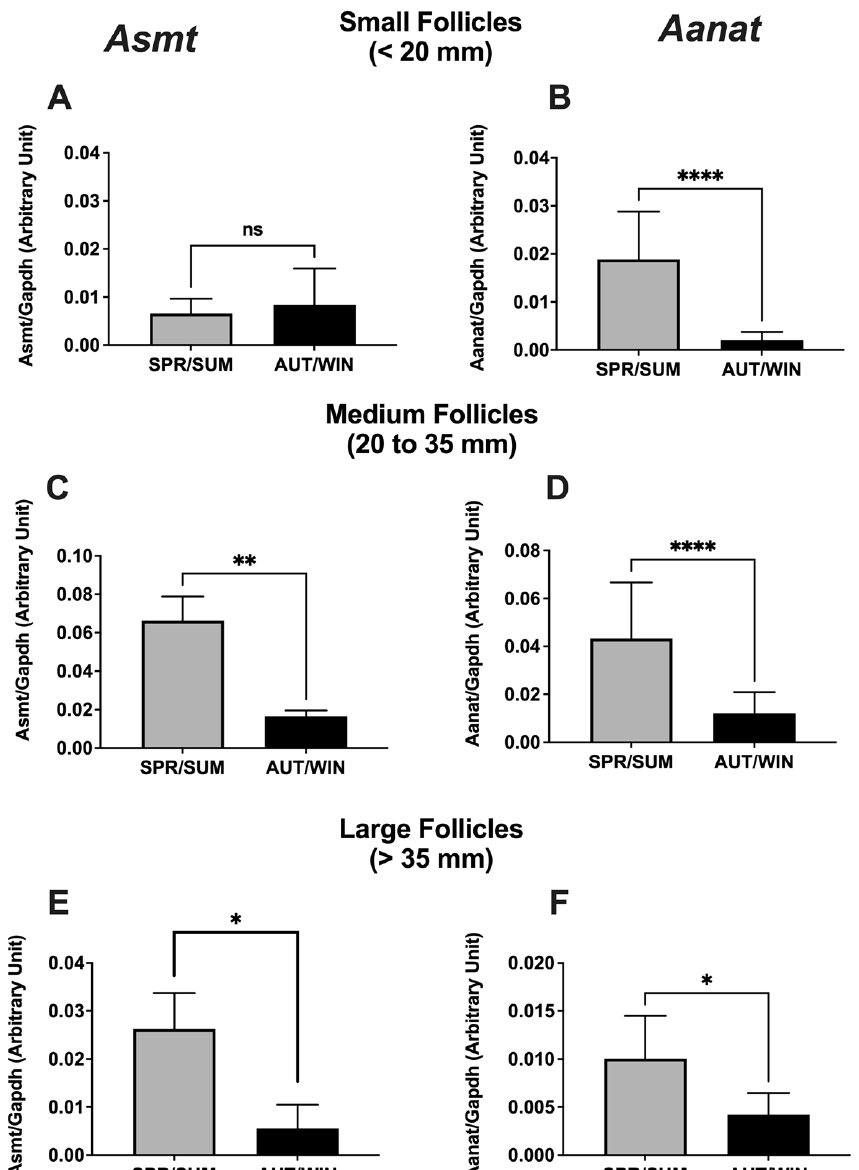
Figure 3. Seasonal distribution of mRNA expression of Asmt ( A , C , E ) and Aanat ( B , D , F ) genes in mare ovarian follicles. SPR/SUM: spring and summer; AUT/WIN: autumn and winter. Non-parametric Mann–Whitney test was used to determine significant differences (plotted as mean ± SEM). Asterisks represent season differences (* p < 0.05; ** p < 0.01, **** p < 0.001). ns: non-significant. Reference gene: Gapdh .